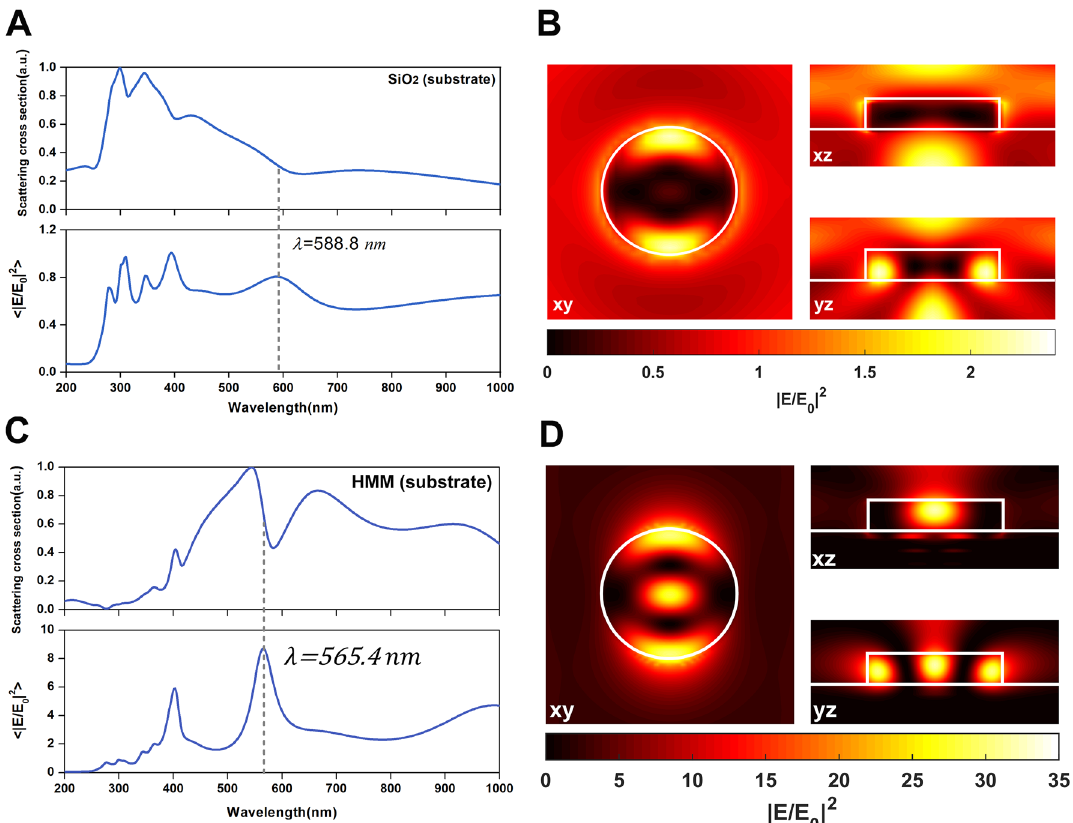
Figure 5: Simulationscattering spectraandfield distributions of thenanostructures. (Color online)LNnanodisk placedonSiO 2 substrate: (A) The top fi gure corresponds to the normalized scattering cross section and the bottom corresponds the intensity enhancement 〈 | E / E 0 | 2 〉 . (B) Normalized electrical fi eld intensity enhancement distributions 〈 | E / E 0 | 2 〉 in xy -, xz -, and yz -planes at the incident wavelength of 588.8 nm correspondtothedashedcuredoutlinedmodeinFigure5A.LNnanodiskplacedatthecenterwith21nmSiO 2 spacerlayerand16pairsofHMM ( ρ (cid:1) 0 . 67) sitting on glass substrate as the simulated nanostructure presented in Figure 1: (C) Top fi gure corresponds to the normalized scatteringcrosssectionandthebottomcorresponds 〈 | E / E 0 | 2 〉 .(D)Normalizedelectrical fi eldintensityenhancementdistributions | E / E 0 | 2 at 565.4 nm. The distributions of the normalized electric fi eld in xy -, xz -, and yz -planes correspond to the dashed cured outlined mode in Figure 5C. The nanostructure of xz and yz cross sections are outline with white solid lines. Here the height ( H = 104 nm) and diameter ( D = 432 nm) of LN nanodisk are the same for all parts of the fi gure. The gray dashed lines show the mode of the highest fi eld